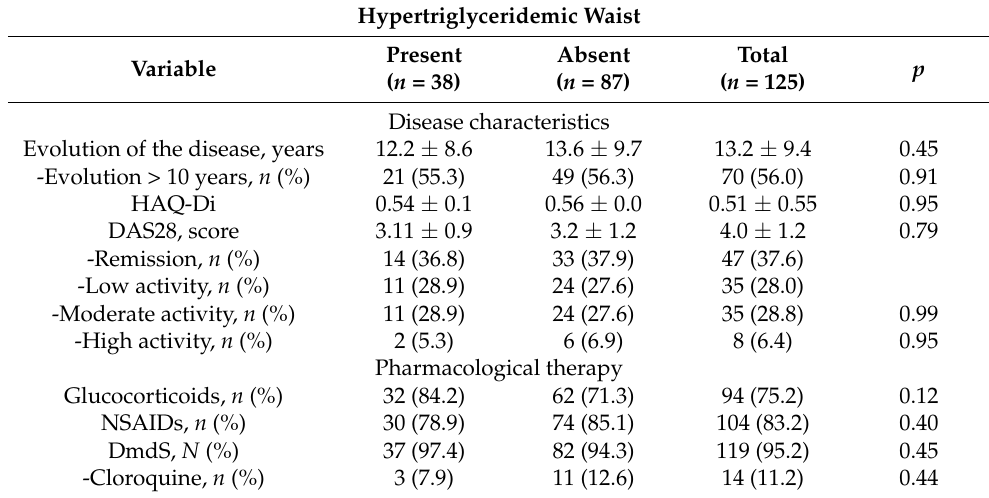
Table 2. Comparison of clinical characteristics according to the hypertriglyceridemic waist phenotype